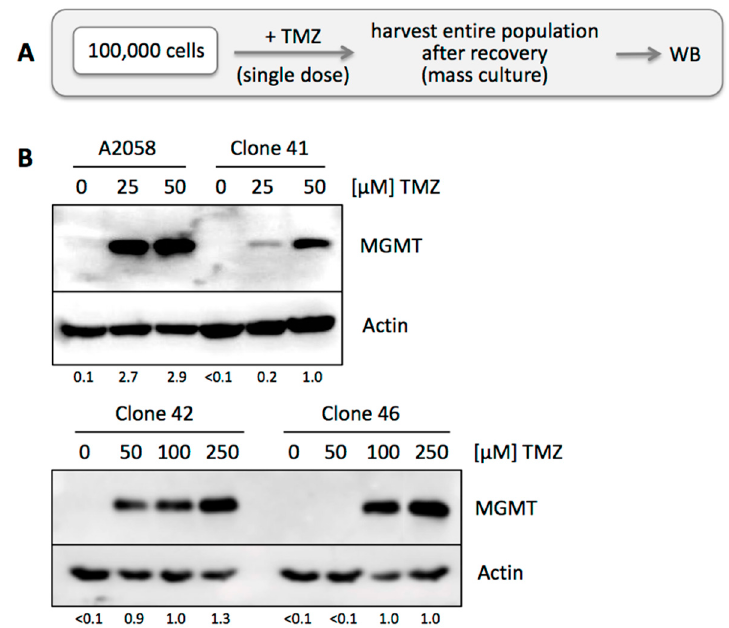
Figure 6. Emergence of MGMT protein in MGMT-negative clone. ( A ) Treatment schedule was as follows: 10 5 cells were seeded into the wells of a 6-well dish and treated with a single dose of TMZ at increasing concentrations from 0 to 50 µ M for 48 h. Surviving cells were kept in culture until the population had regrown sufficiently to harvest enough cells for WB analysis. ( B ) Cell lysates were prepared from mass cultures of surviving A2058 cells and from clone 41, followed by WB analysis of MGMT protein levels. Actin was used as a loading control. Numbers under the blots indicate quantification of MGMT bands, with reference to the actin signal, and relative to the intensity in the right lane (set at 1.0); <0.1 indicates below detection limit.